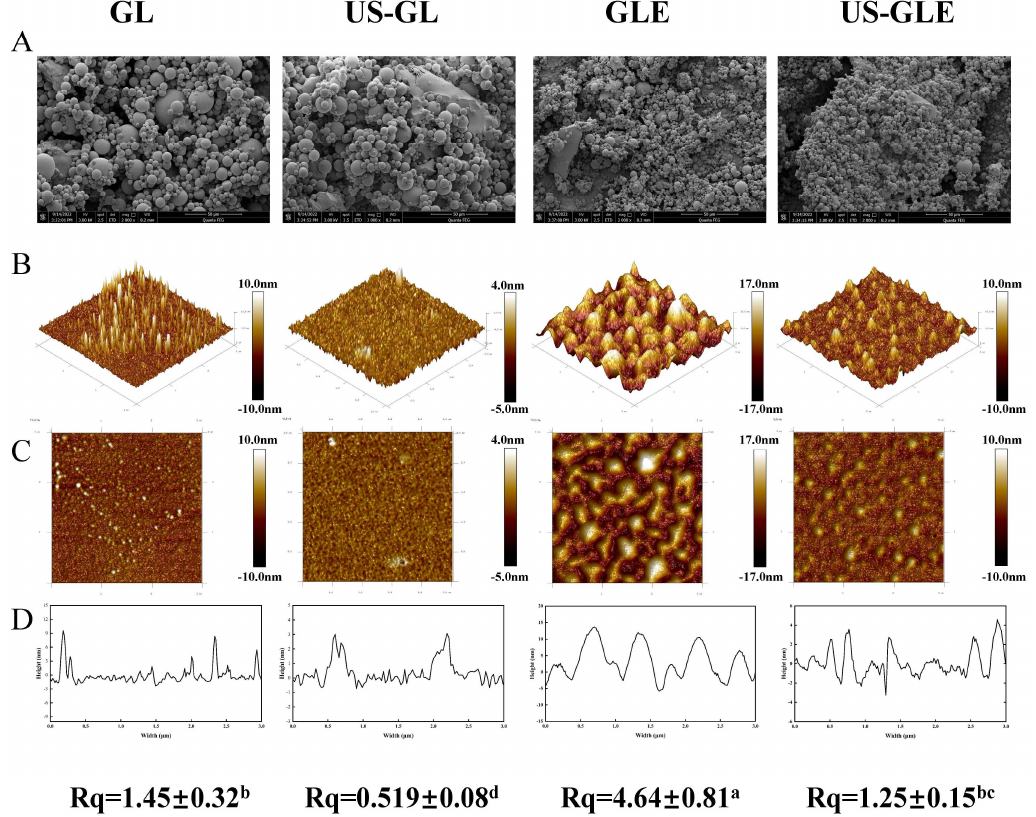
Figure 3. Results of microstructure observation samples. Scanning electron microscopy (SEM, Magni- fication of 5000 times) ( A ), 3D distribution image ( B ), 2D distribution image ( C ), cross section ( D ) and surface roughness (Rq) of samples, in observation of GL, US-GL, GLE, and US-GLE. “±” refers to the standard deviation. Values with different letters (a–c) in the figure indicate significant differ- ences ( p < 0.05).